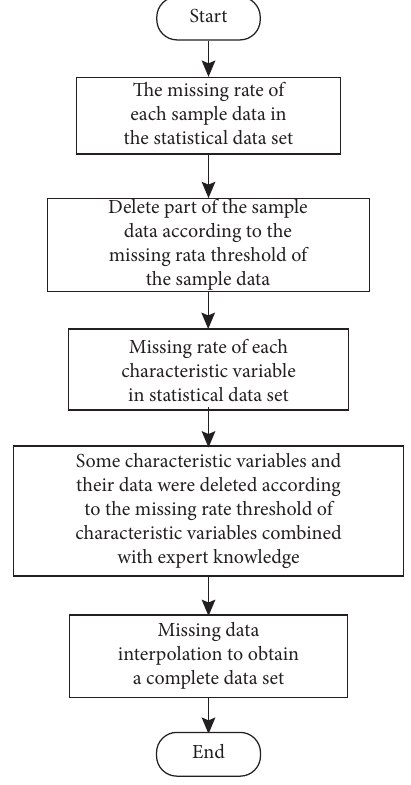
Figure 3: Missing data processing